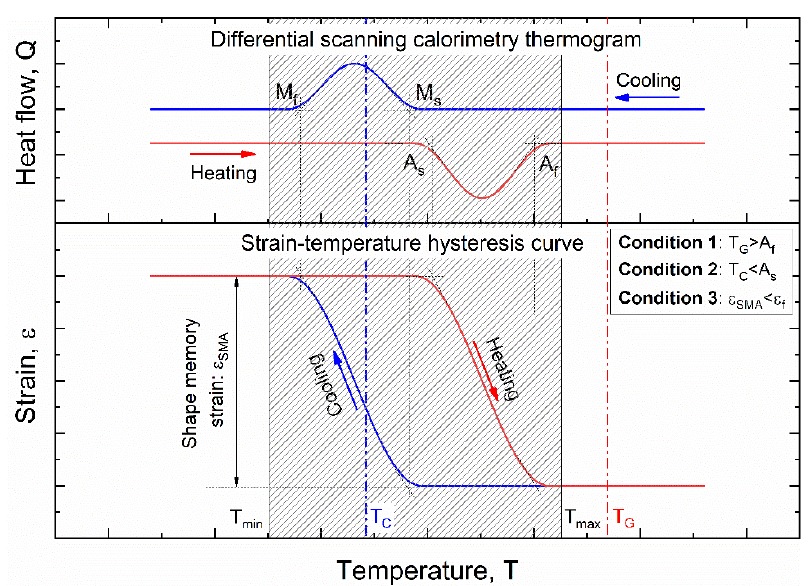
Figure 1. Schematic depiction of the transformation mechanisms in SMAs, in terms of DSC curve and strain – temperature hysteresis, and main thermo-mechanical constraints for SMA – polymer integration. Table 1. Selected SMA and polymer materials for smart composite.